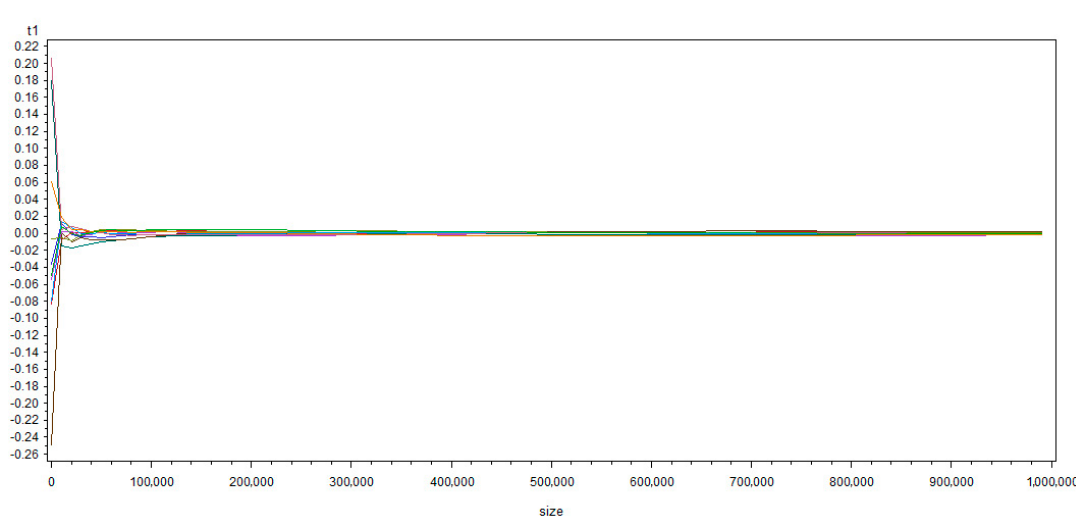
Figure 2. Evolutions of (cid:98) β T when the sample size increases from 100 up to 1,000,000.